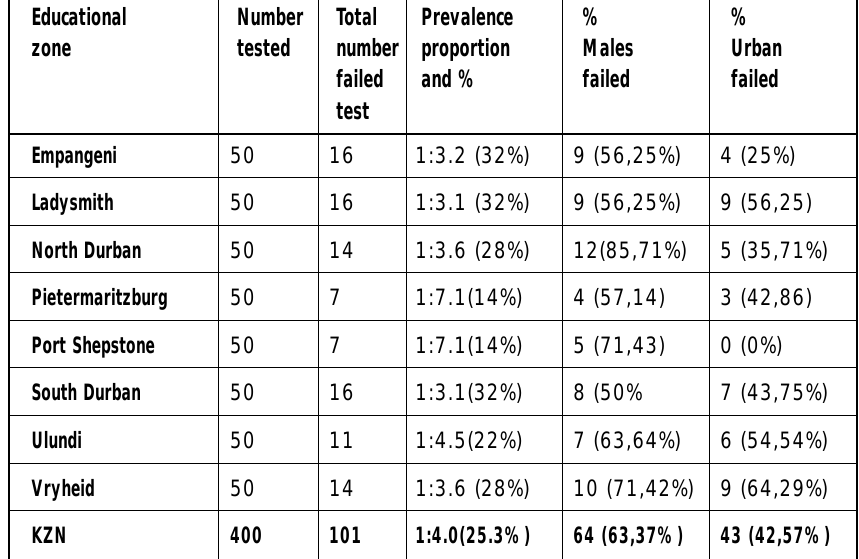
Table 2: Number of children tested, Gender and urban and general prevalence proportion and % in tested children by educational